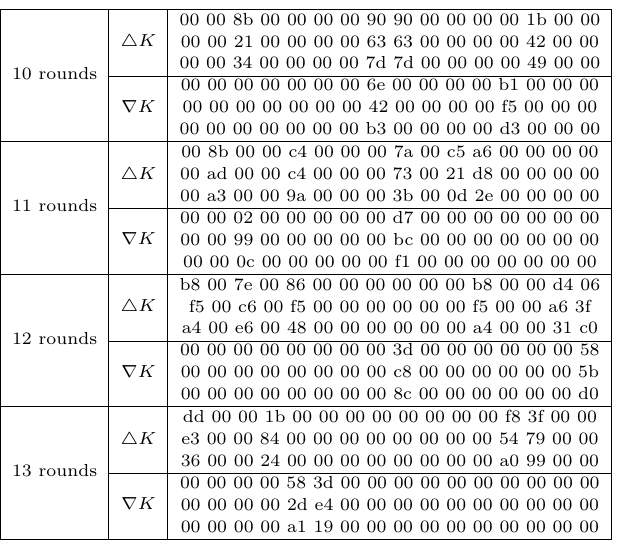
Table 6: Master tweakey differences for distinguishers of